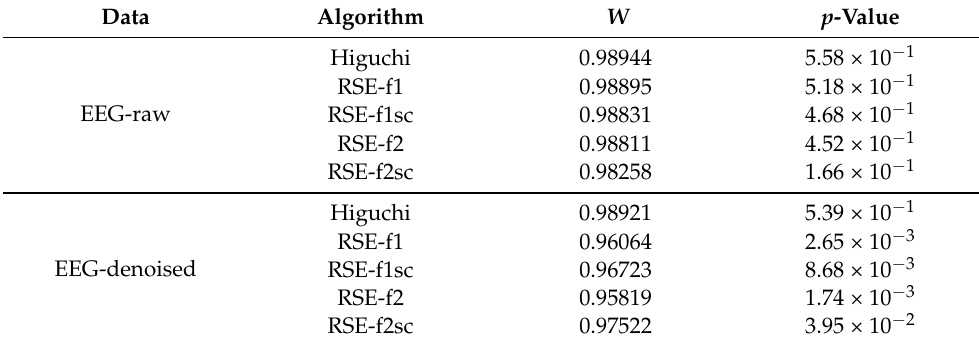
Table 2. Shapiro–Wilk test results of the values of D c difference between seizure and normal